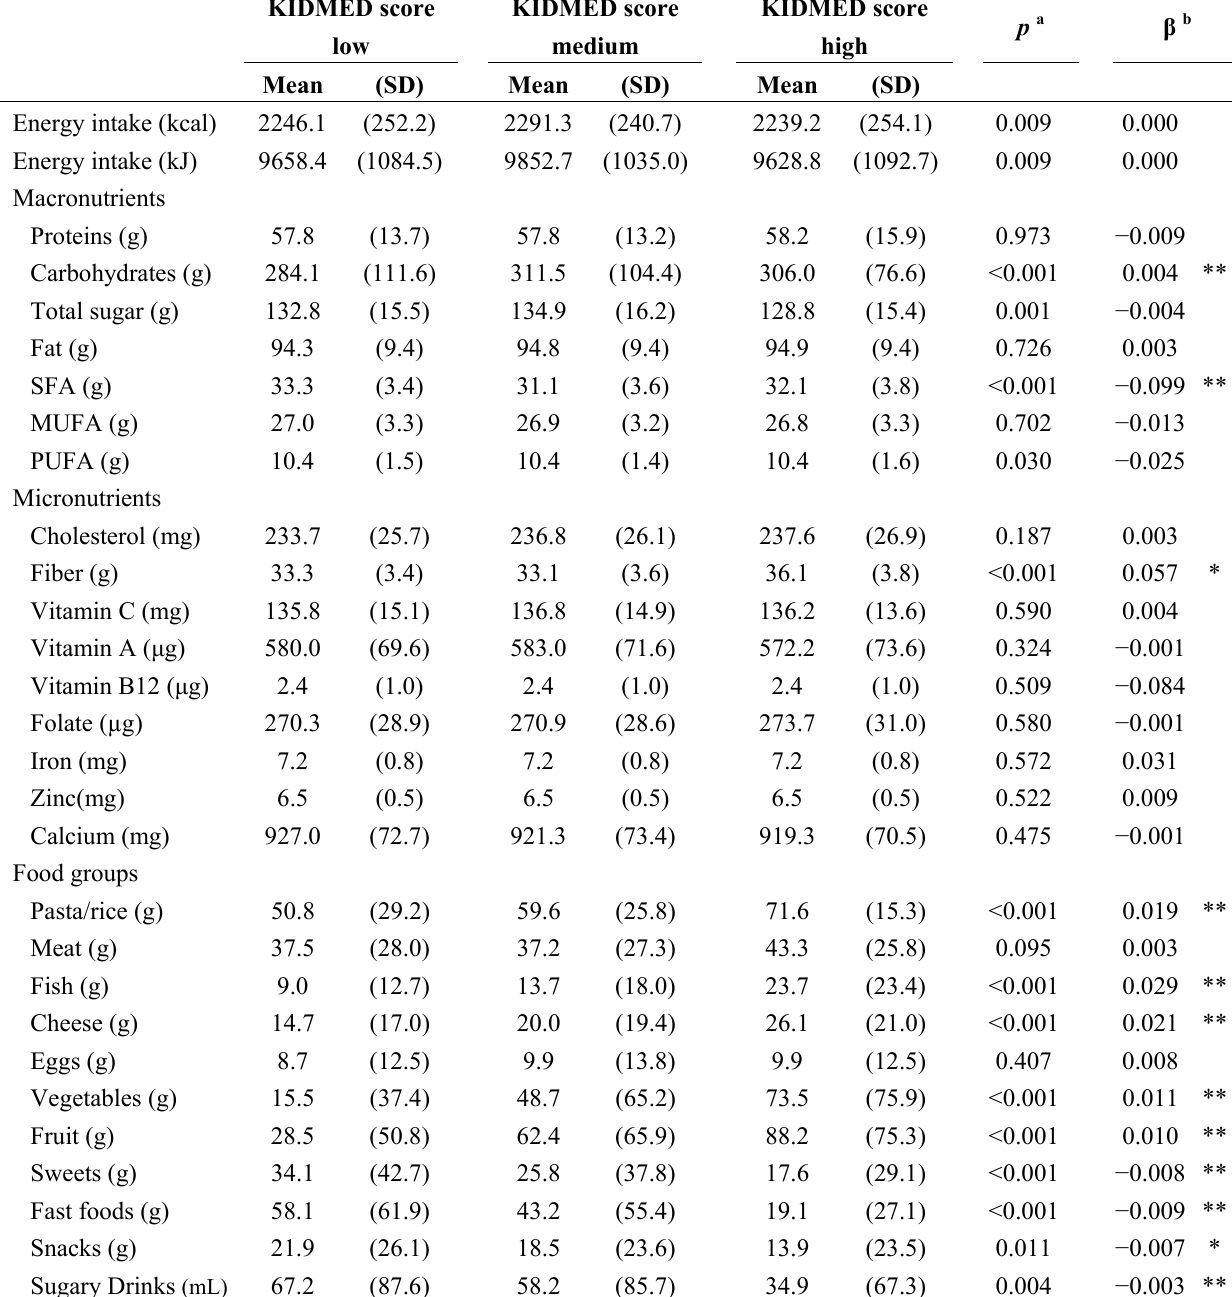
Table 4. Daily energy, nutrients, and food groups intake of the study population, by tertiles of KIDMED diet adherence scores, and linear regression analysis with the KIDMED